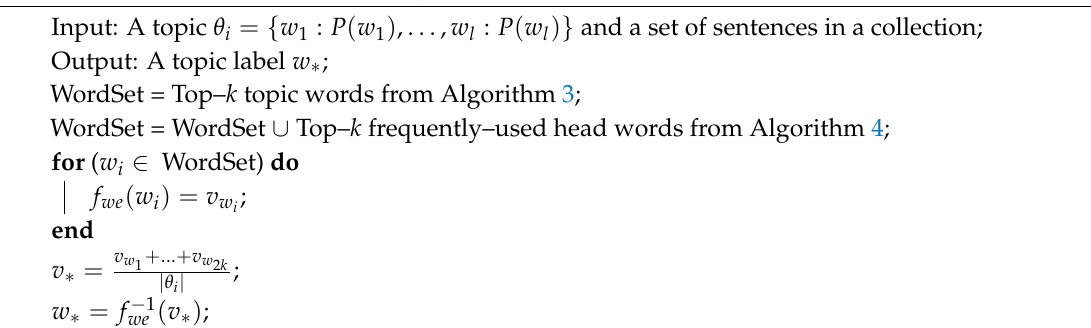
Algorithm 5: The third aspect auto-generation